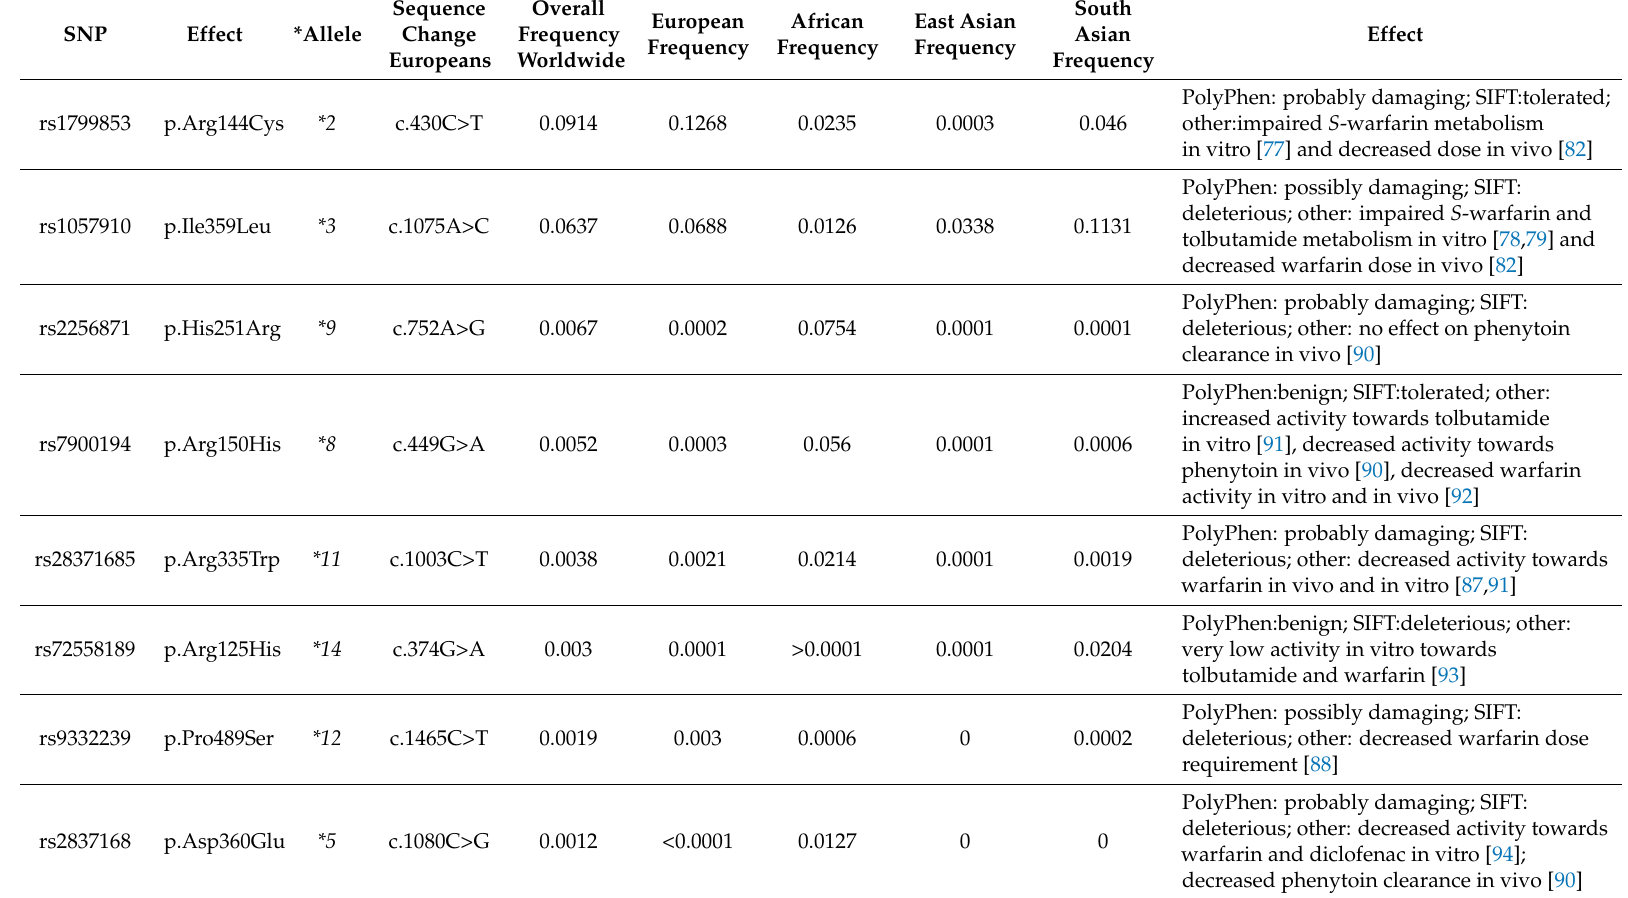
Table 2. Variant CYP2C9 alleles and frequencies in different ethnic